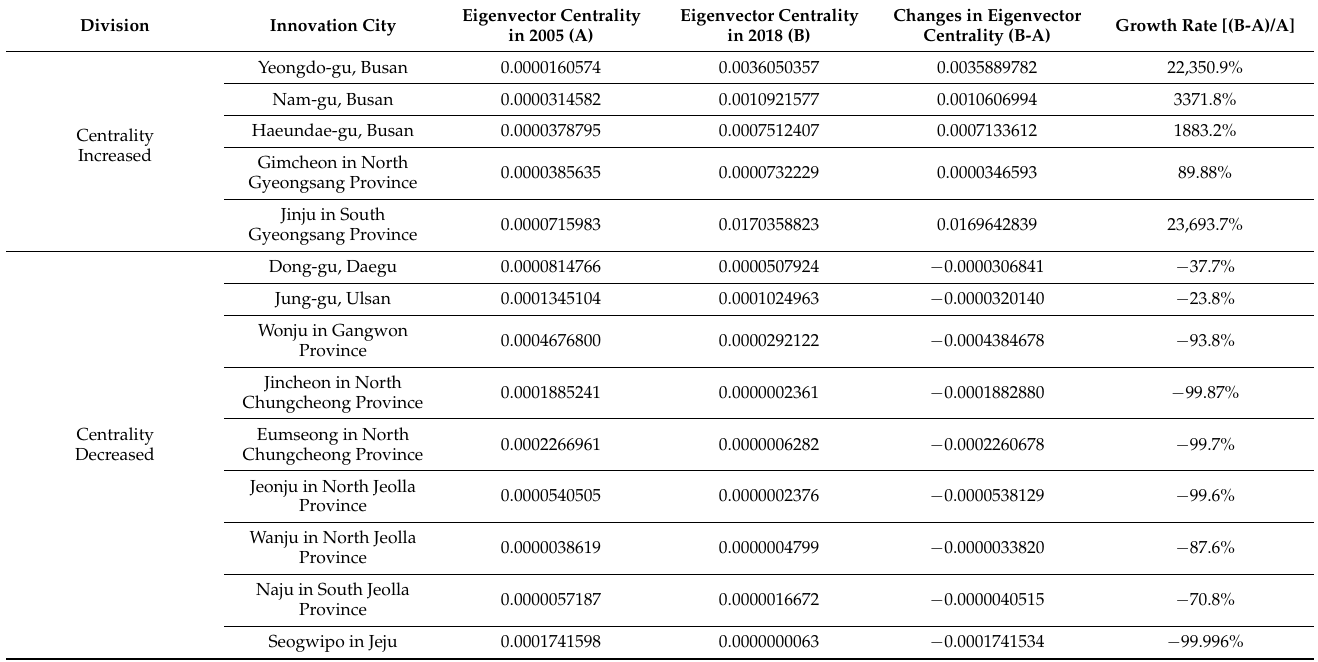
Table 5. Changes in eigenvector centrality of Innovation